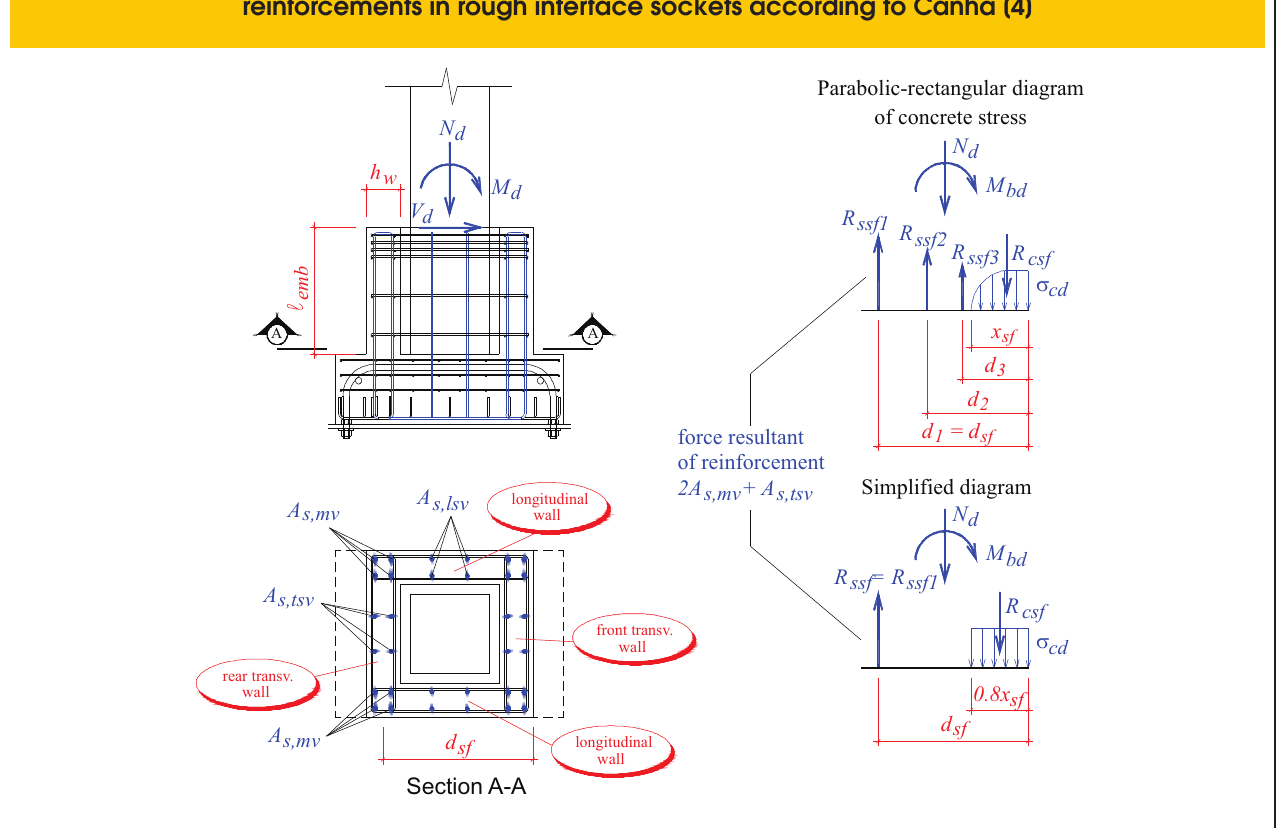
Figure 7 – Schematic representation of force for the determination of vertical reinforcements in rough interface sockets according to Canha